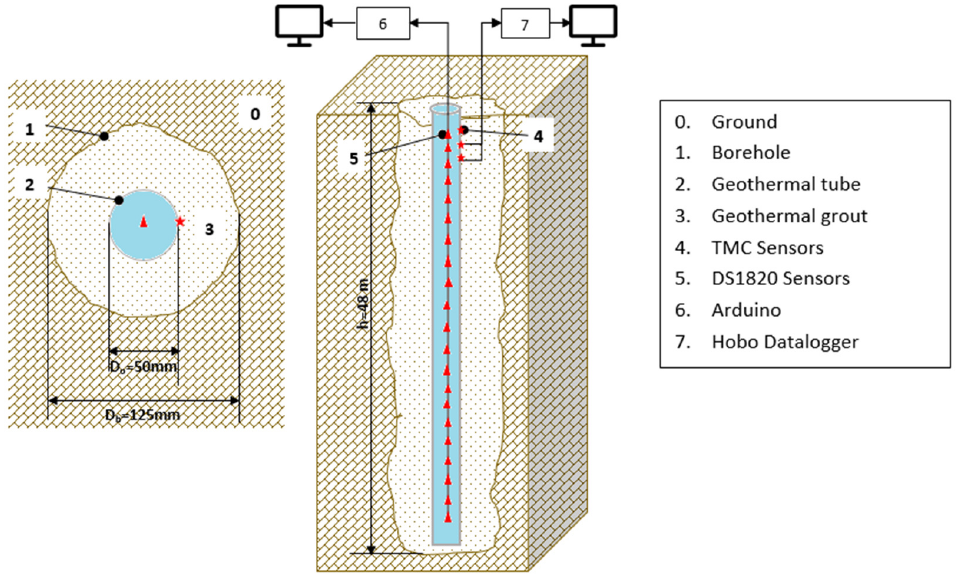
Figure 5. Experimental set-up showing the geothermal borehole, pipe, temperature sensors, and a cross section of geothermal borehole Q-Thermie Uniovi 2, (figure not to scale). Red triangle corresponds to number 5. Red star corresponds to number 4.